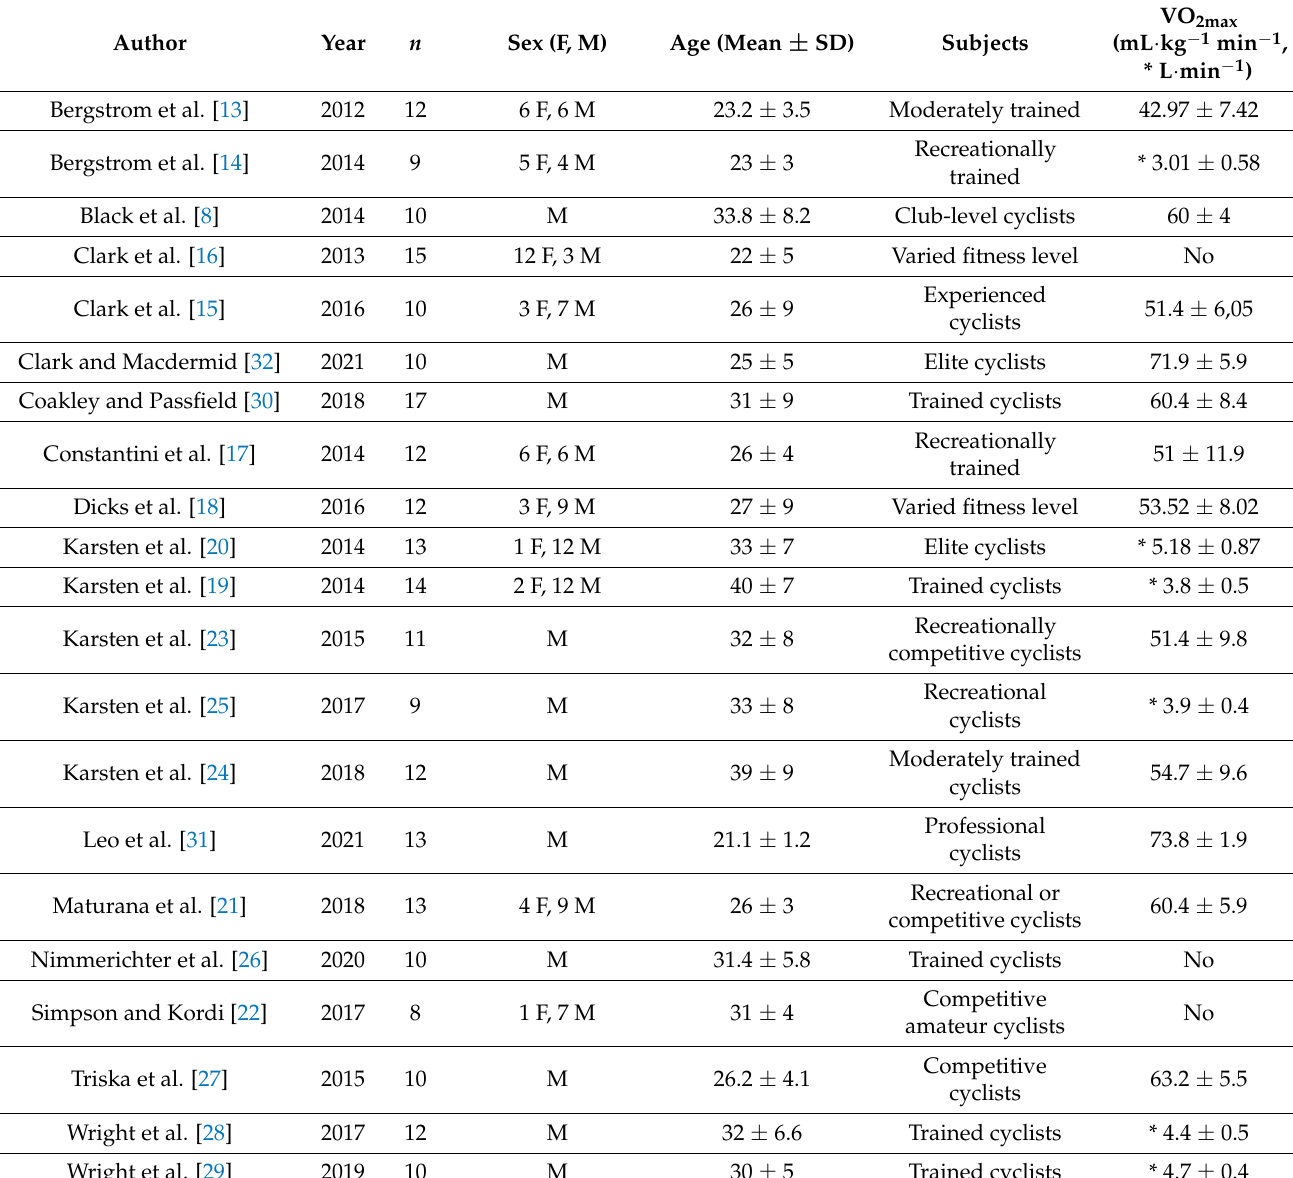
Table 1. Describing participants from all included